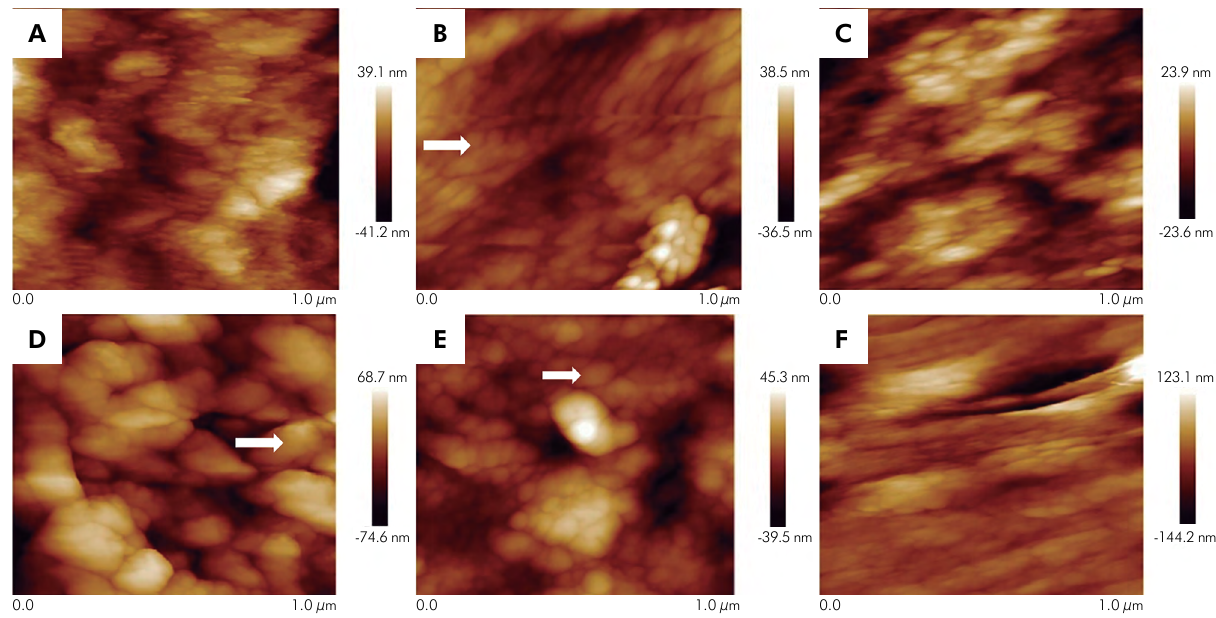
Figure 3. Two-dimensional images of the dentin surfaces etched with the different solutions using AFM. (A) 5% phosphoric acid (AC5). (B) 10% phosphoric acid (AC10). (C) 20% phosphoric acid (AC20). (D) GSE5. (E) GSE10. (F) GSE20. The periodicity of the collagen fibrils (arrow) is observed in AC10. In GSE5, GSE10, and GSE20, the collagen fibrils formed globular structures (arrows), which are more evident in